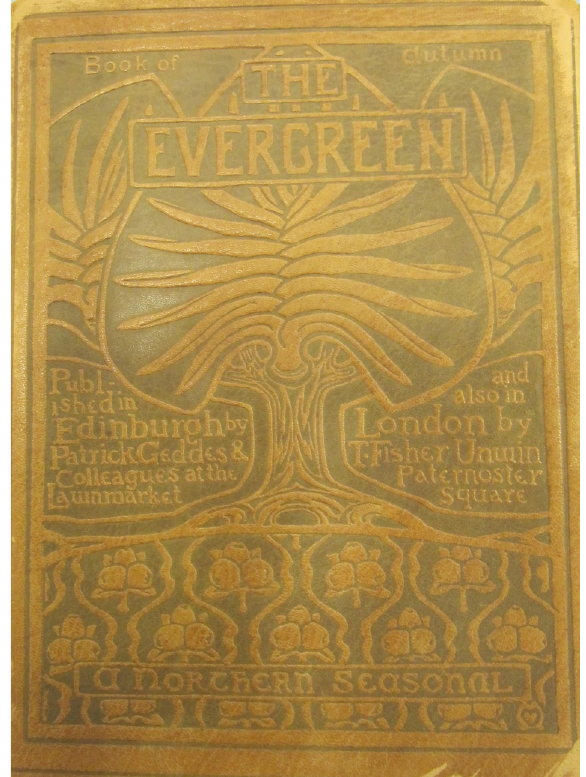
Fig. 1b Evergreen: A Northern Seasonal (Autumn 1895), front cover, private